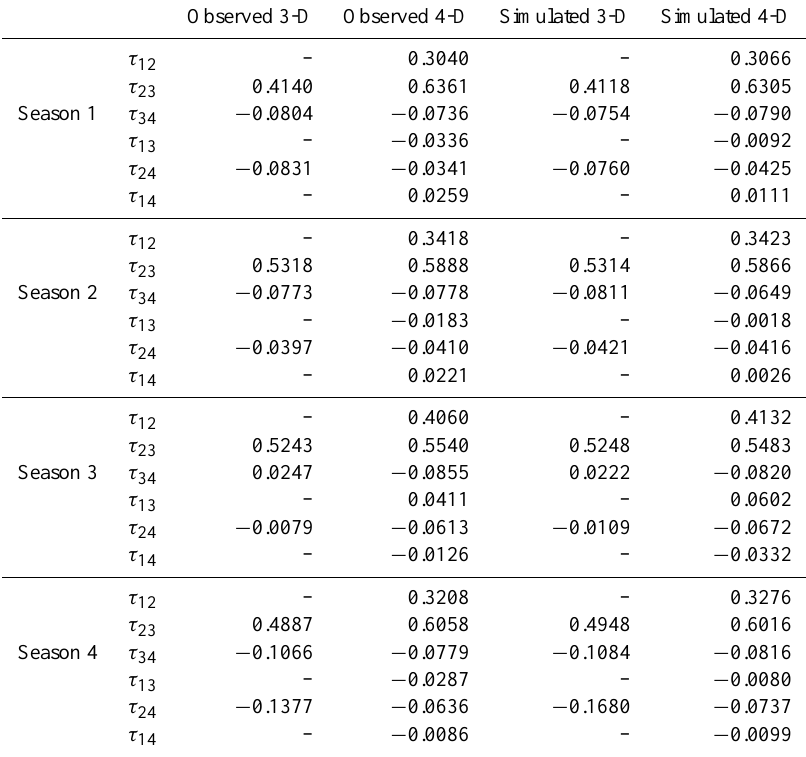
Table 2. Correspondence between the observed and simulated pairwise dependences among (p d ,W,V,D) , expressed as Kendall’s tau τ K . Observed